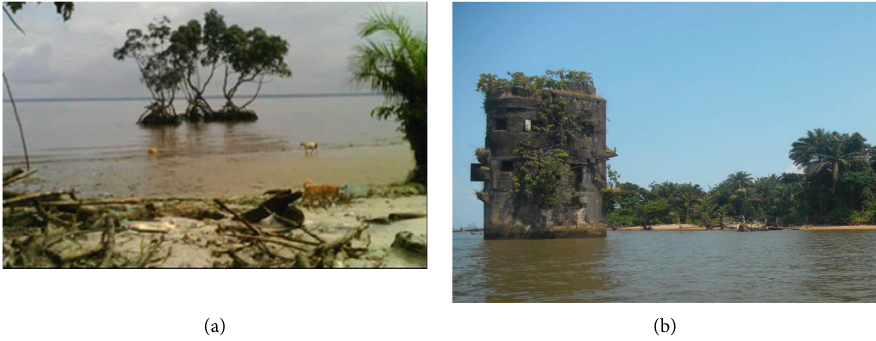
Figure 7: Sea advance accelerating coastal erosion. (a) Kwansi beach. (b) Dahomey